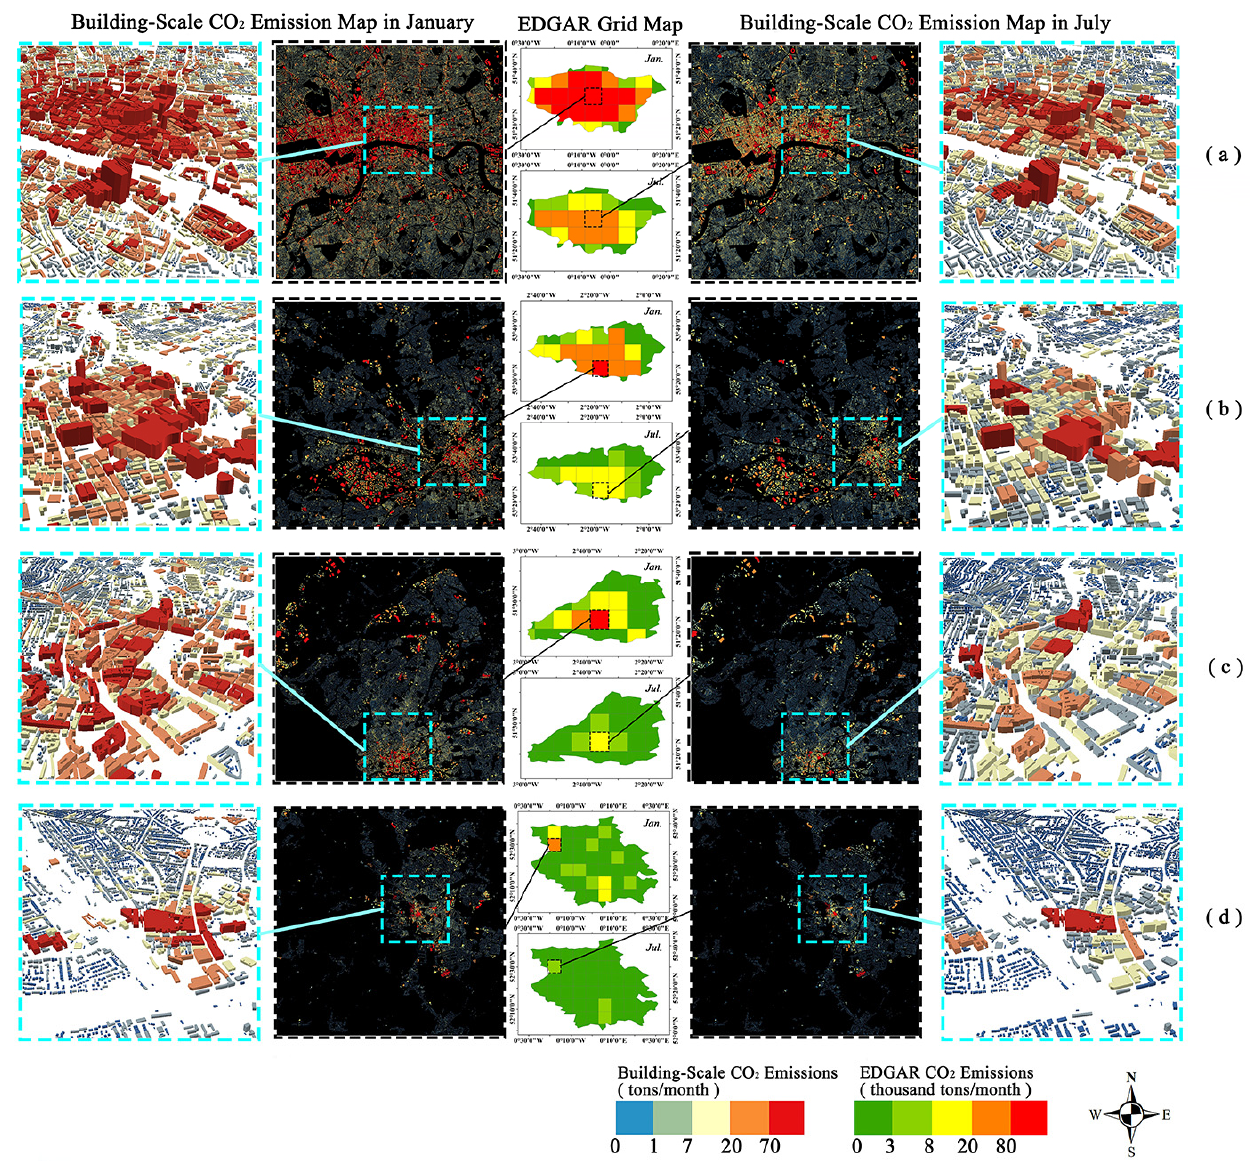
Figure 11. Comparison of the spatial patterns of January and July CO 2 emissions in four regions: ( a ) Greater London, ( b ) Greater Manchester, ( c ) Bristol, and ( d ) Cambridge.